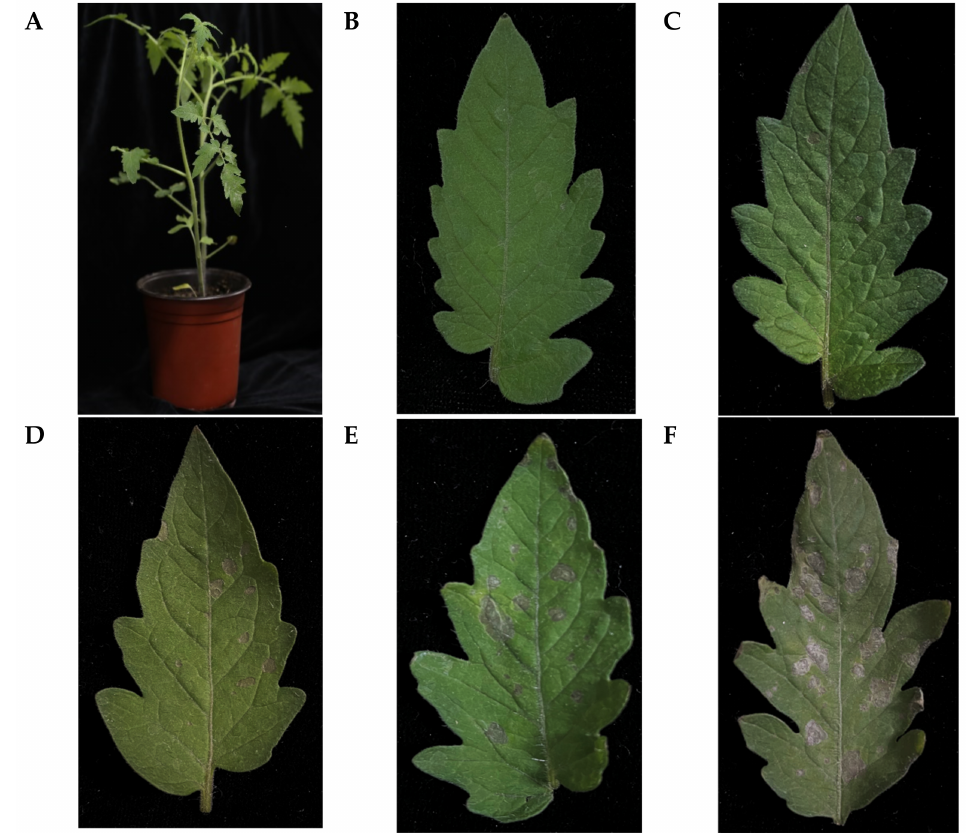
Figure 6. The pathogenicity test was mediated by the EPS isolated from Clavibacter michiganensis on tomato leaves. ( A ) Whole plants were photographed after 7 days of infiltration. ( B – F ) Tomato leaves were treated with water control and 0.5, 1, 2, and 5 mg/mL of EPS solution, respectively. All pictures were captured after 7 days of